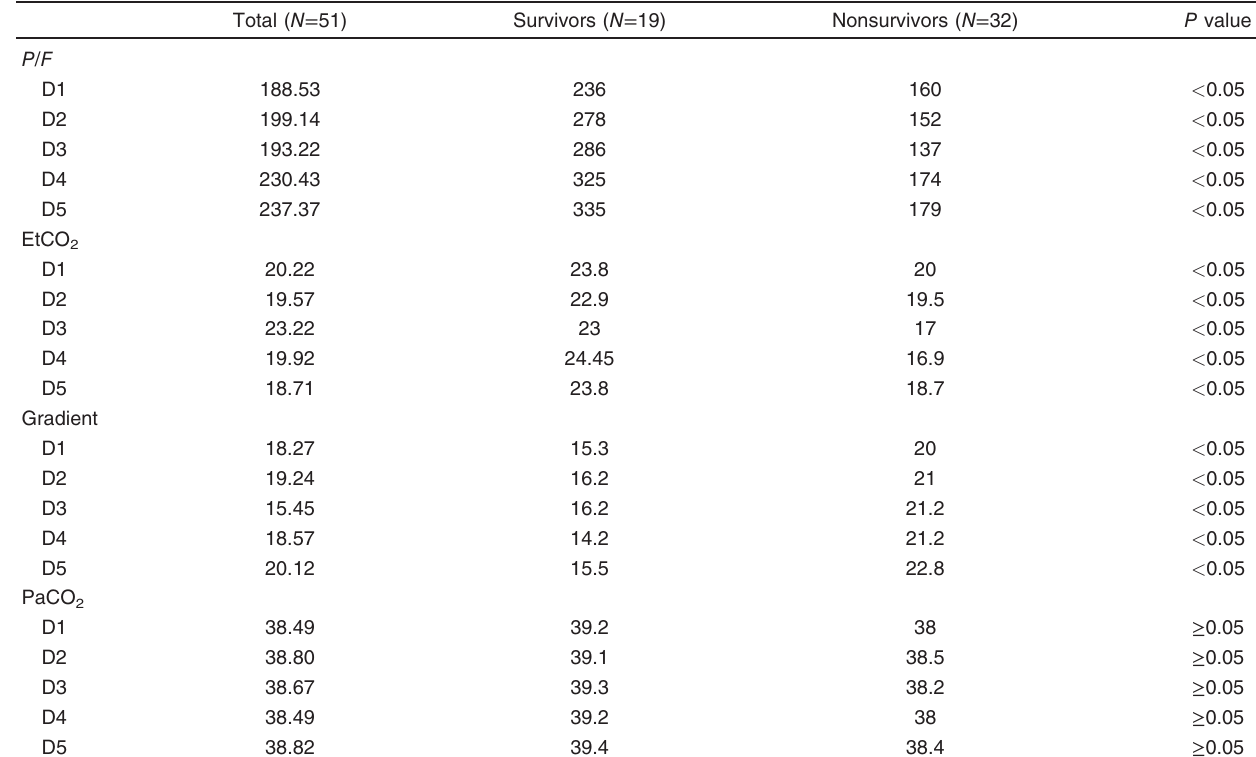
Table 2 Comparison between survivors and nonsurvivors